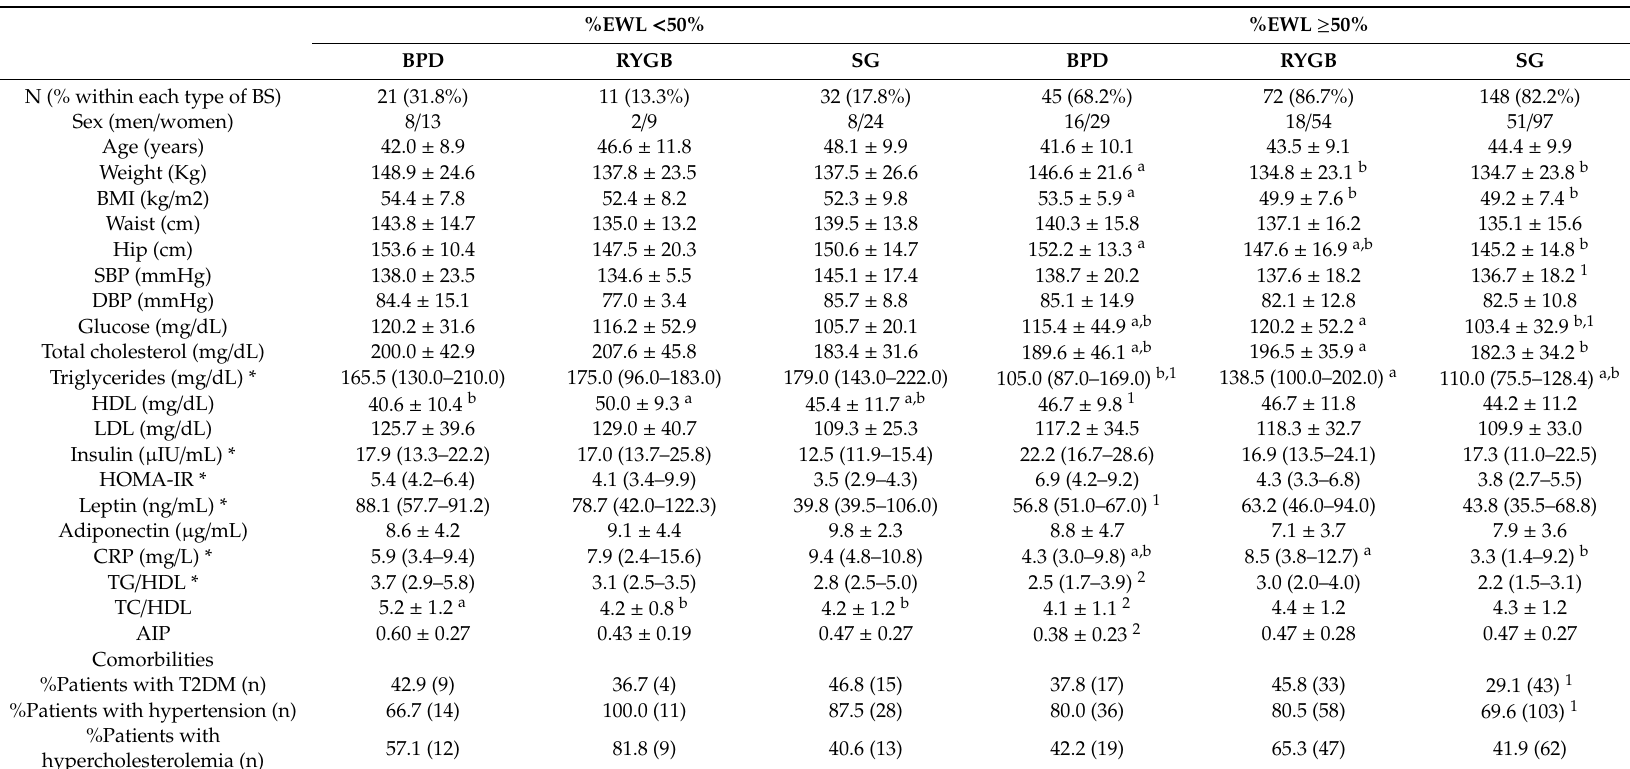
Table 4. Baseline characteristics of patients with morbid obesity classified according to %EWL and the type of bariatric